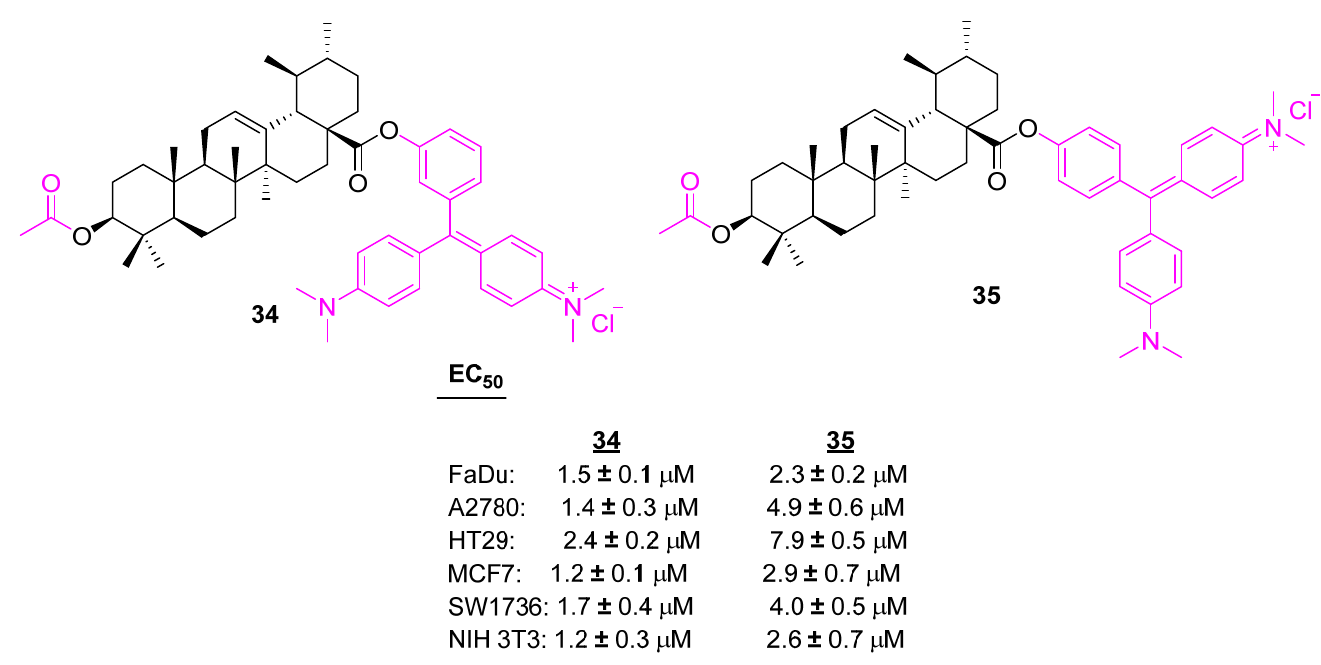
Figure 21. Structure of 33 .